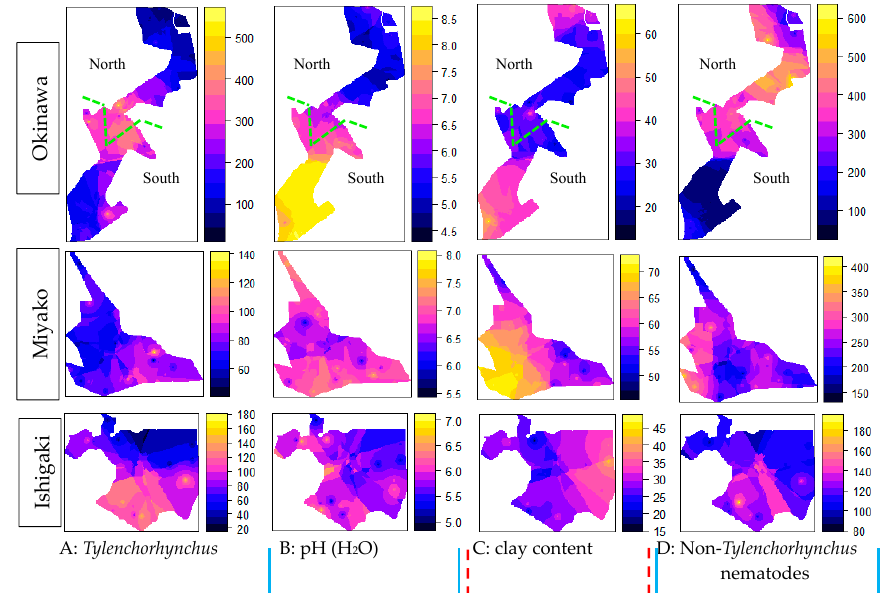
Figure 5. Spatial distribution of A: the abundance of Tylenchorhynchus nematodes 20 g soil − 1 , B: pH (H 2 O), C: clay content (%) and D: the abundance of non- Tylenchorhynchus 20g soil − 1 in Okinawa, Miyako, and Ishigaki predicted by the inverse distance weighting (IDW) approach. The green dotted line in Okinawa’s figure was to separate North and South regions. To the abundance of Tylenchorhynchus in the mixed-effect model, the blue solid line at the bottom has a positive relationship, and the dotted red line has a negative relationship.